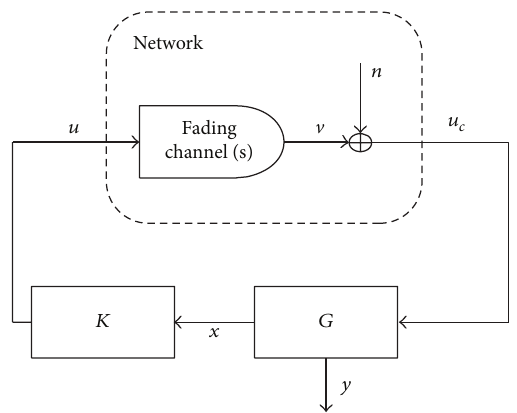
Figure 1: State feedback control by one-parameter controller over AWGN fading